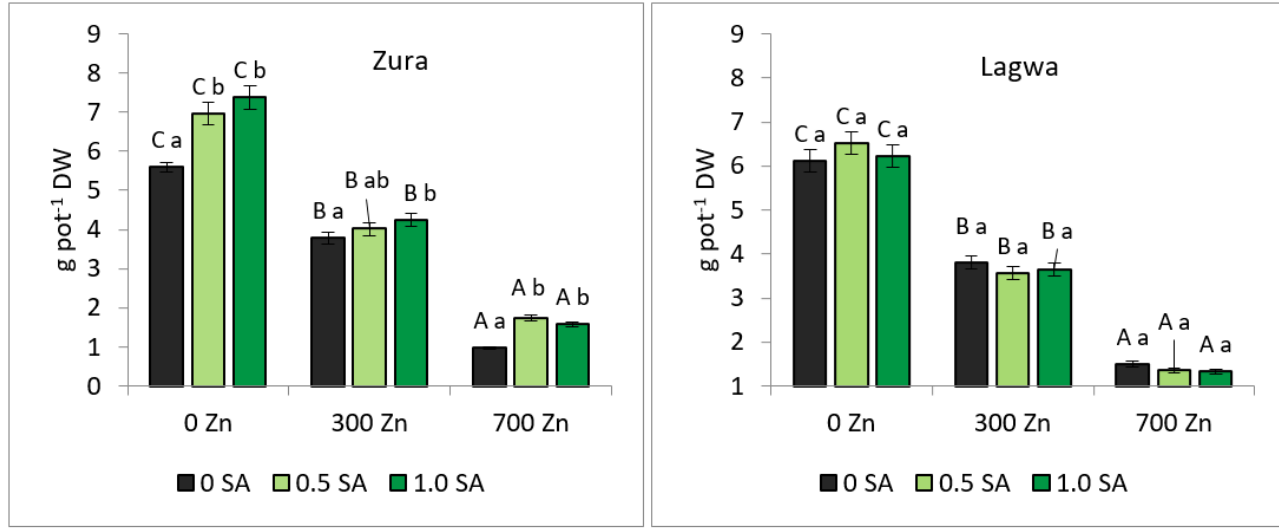
Figure 1. Biomass of wheat shoots–mean over 2 years. Means marked with different capital letters differ significantly between the Zn levels within each level of SA, and means marked with different small letters differ significantly between the SA levels within each level of Zn (according to Tukey’s HSD test at p < 0.05). Vertical bars represent standard errors (n = 4).